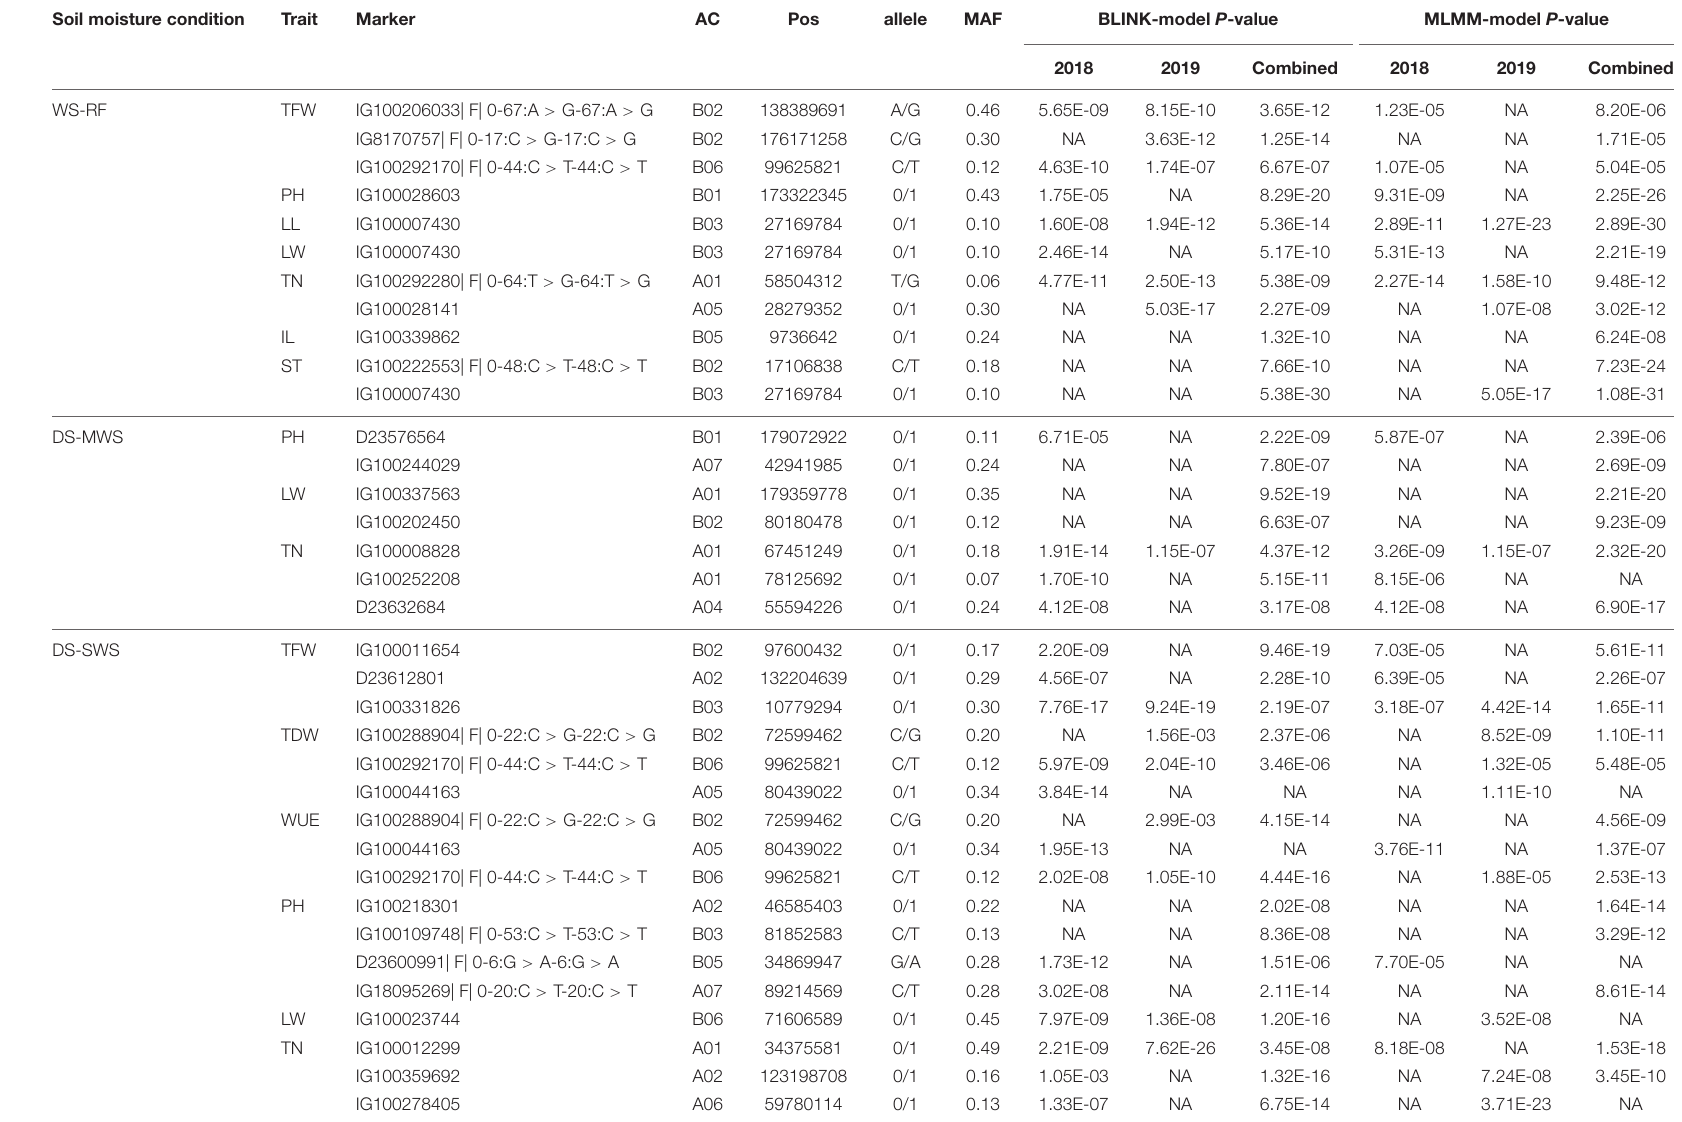
TABLE 3 | Markers significantly associated with agro-morphological traits, their genomic positions, contrasting alleles, and minor allele frequency. Soil moisture